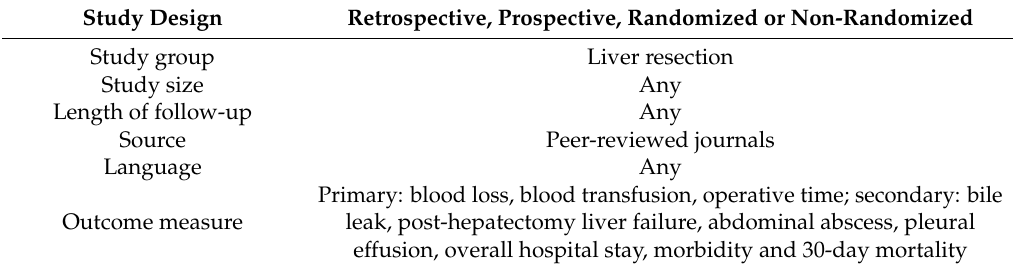
Table 1. Criteria for the inclusion of